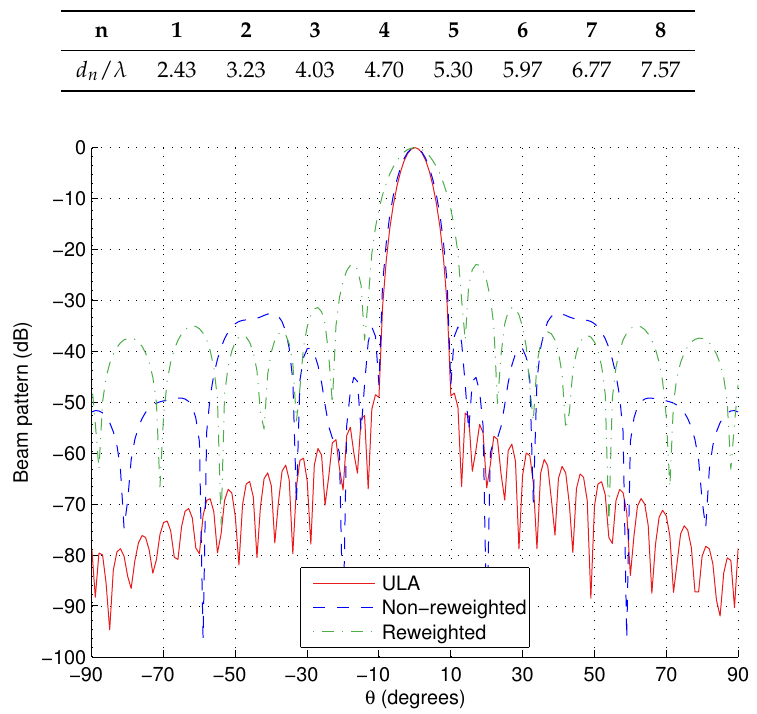
Figure 2. Responses for broadside design example, M =